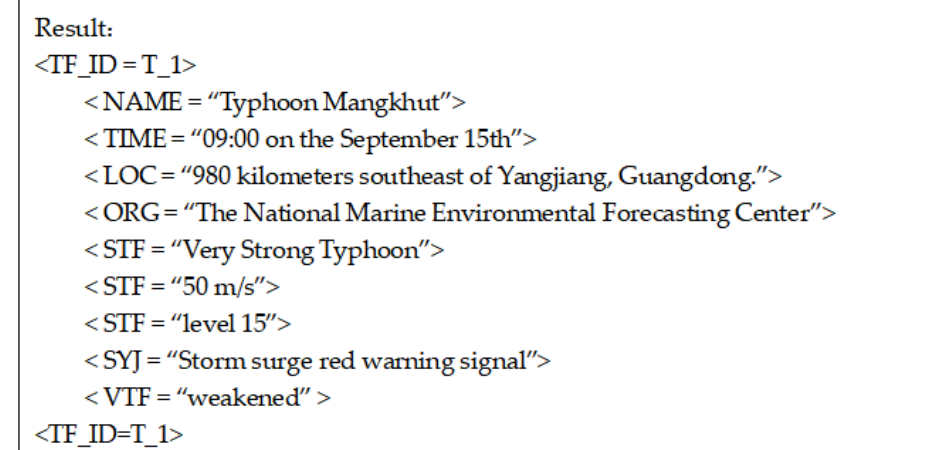
Figure 9. Results of typhoon event-elements extraction (In en-US).